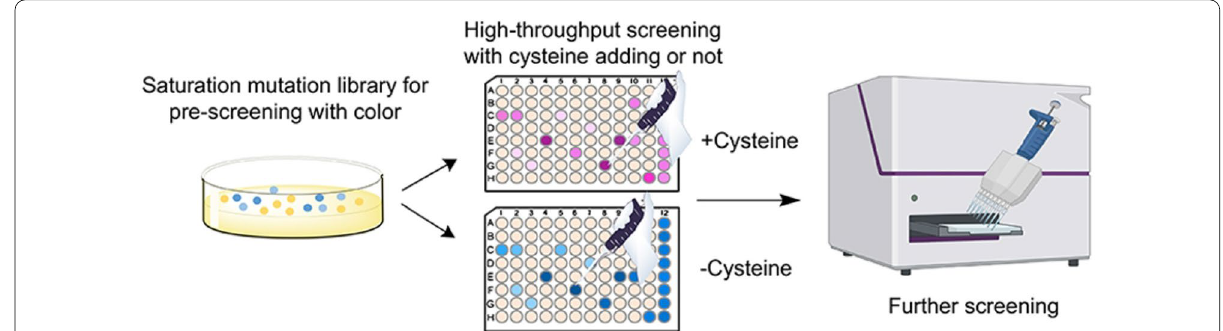
Fig. 3 Schematic representation of the high‑throughput screening process for the activity assay of indirubin. After pre‑screening with color, cysteine was added to the secondary culture to obtain the pure indirubin, and then absorbance was measured by UV spectrophotometry microplate